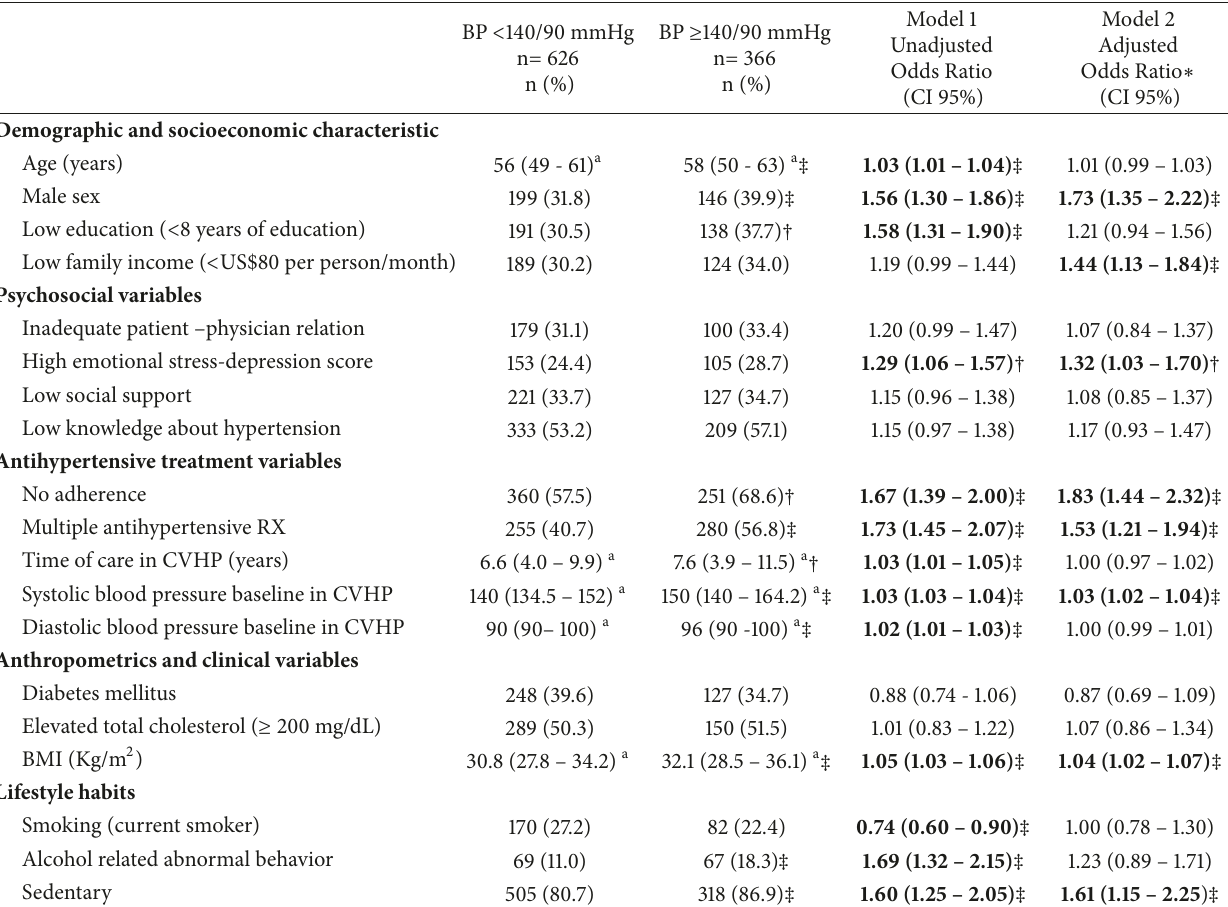
Table 2: Multivariable adjusted odds ratio for uncontrolled BP ( ≥ 140/90 mm/Hg) in hypertensive patients followed in the Cardiovascular Health